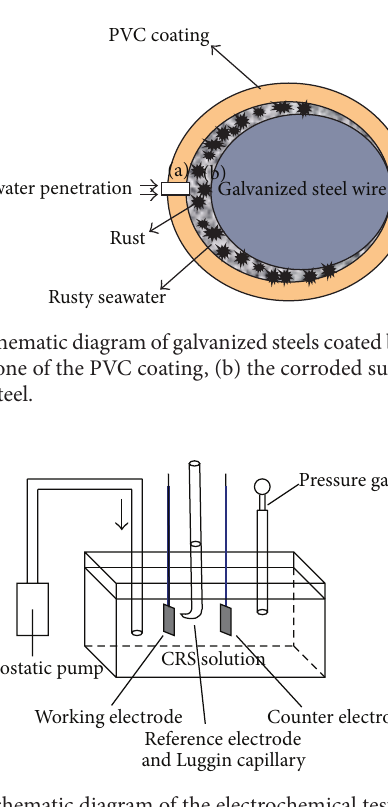
Figure 2: Schematic diagram of the electrochemical test cell under different hydrostatic pressures in CRS solution.